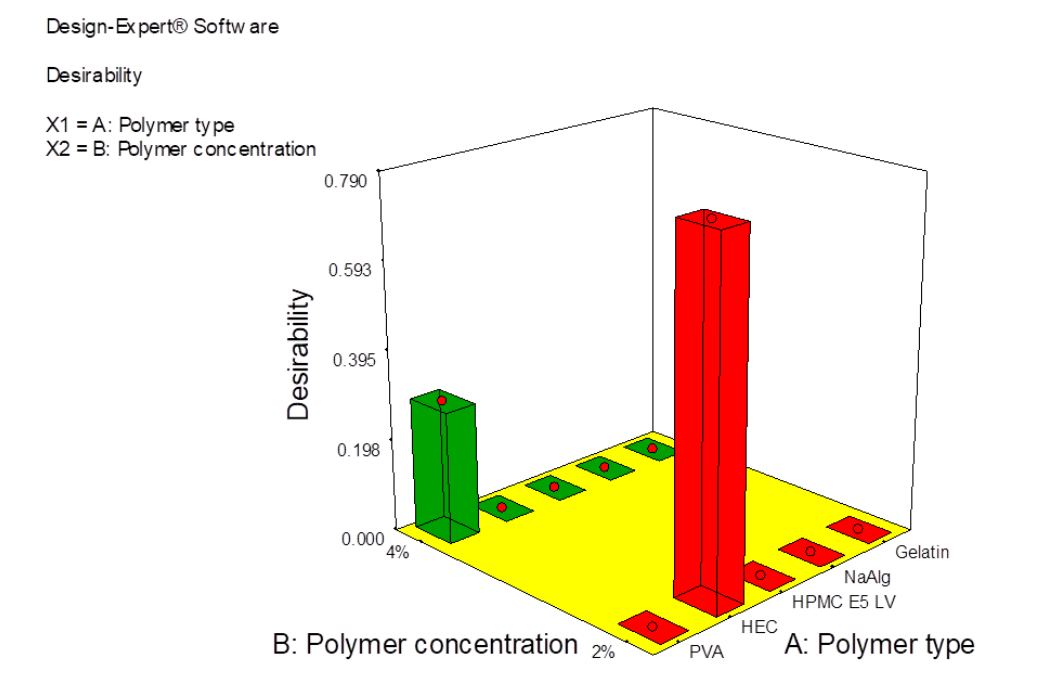
FIGURE 6 - Desirability outcomes of SRT